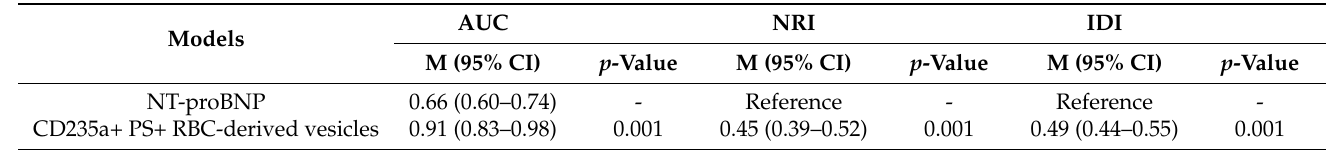
Table 3. The comparisons of NT-proBNP and CD235a+ PS+ RBC-derived EVs discriminative poten- cies for poor glycemic